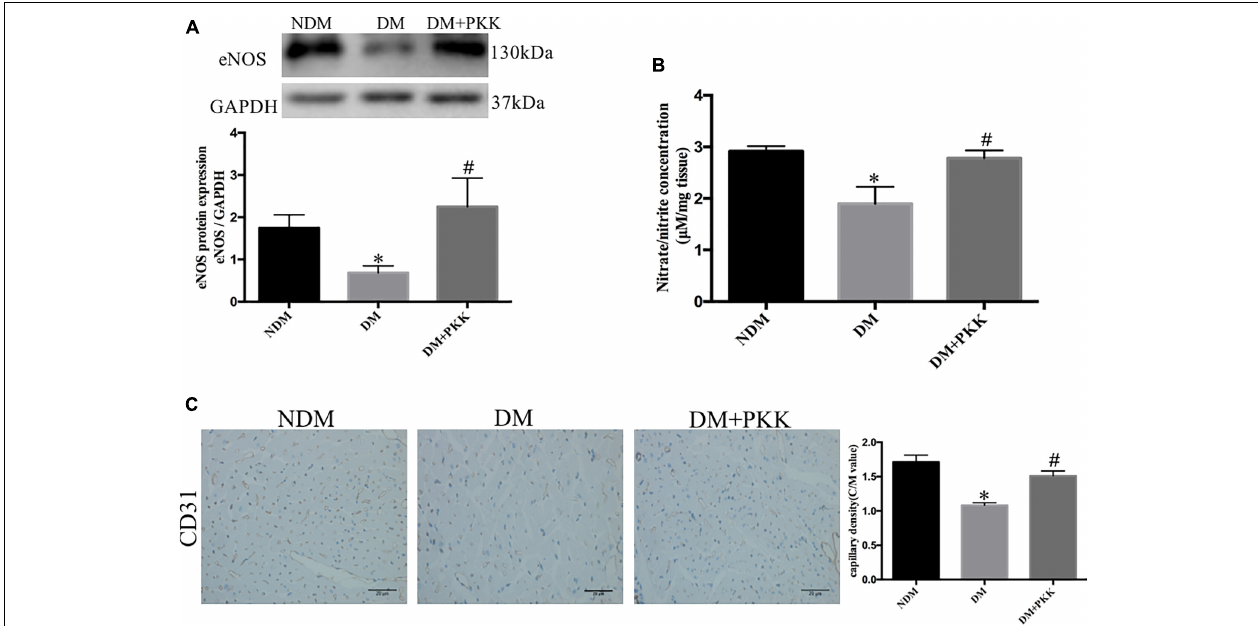
FIGURE 7 | Pancreatic kallikrein administration promoted nitric oxide production in the heart of STZ-induced diabetic rats. (A) The protein expression and quantitative data of anti-endothelial nitric oxide synthase (eNOS) in the NDM, DM, and DM + PKK groups. (B) Myocardial nitrate/nitrite concentrations in diabetic rats were lower than that in the NDM group and DM + PKK group. (C) CD31 staining in NDM, DM, and DM + PKK group, respectively; and the comparison of C/M values among three groups. The magnification of light microscope is 40. The brown staining indicates the CD31+ capillary endothelial cells. Myocardial sections were counterstained with hematoxylin (the blue nucleus staining). Each sample for qPCR and western blot was repeated for three times. Values are mean ± SEM, n = 6 per group; ∗ P < 0.05 vs. NDM group; # P < 0.05 vs. DM + PKK